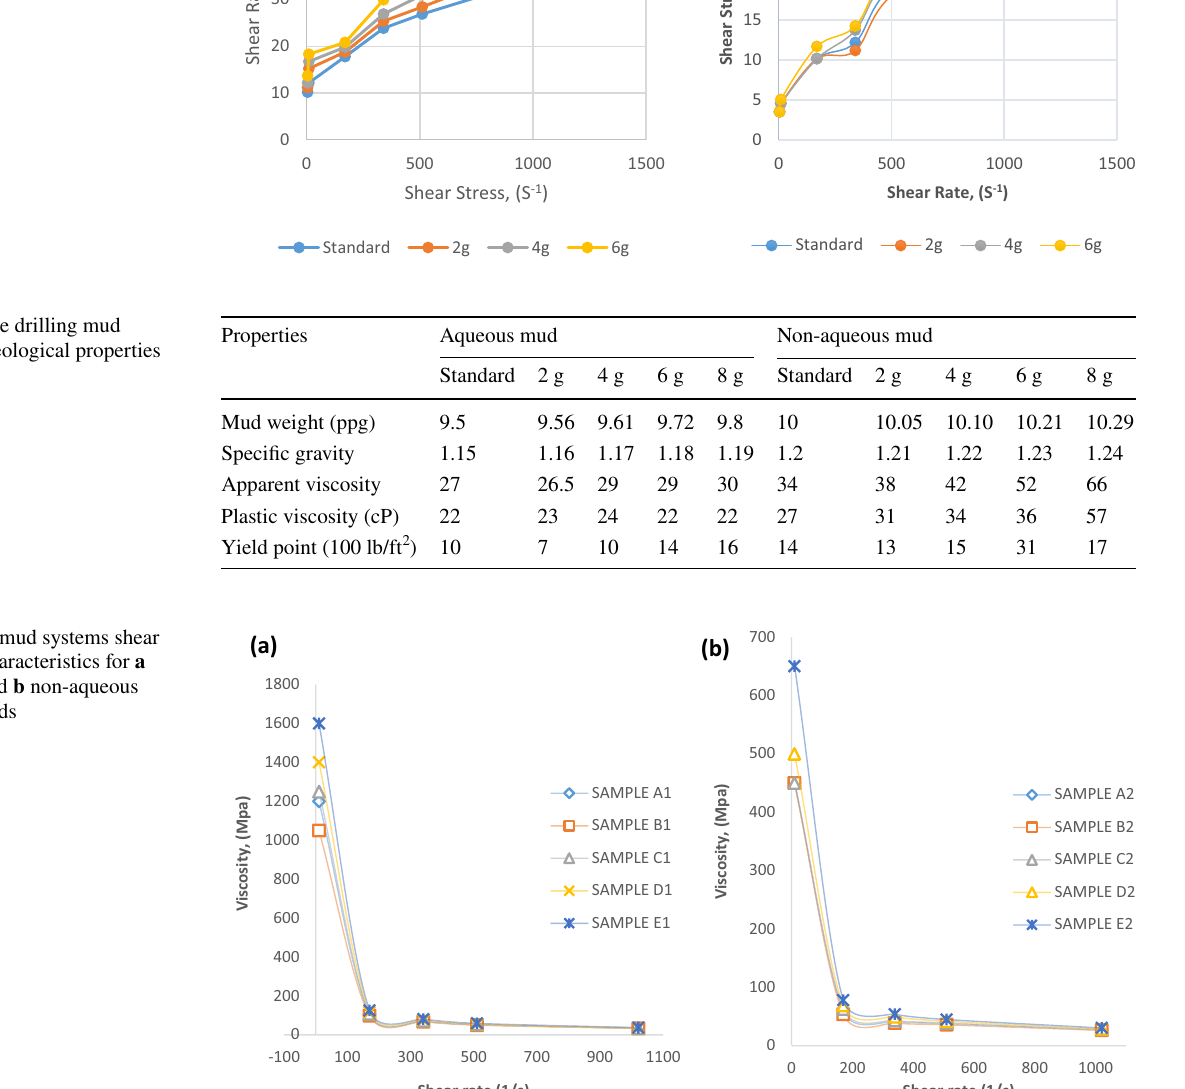
Table 4 The drilling mud systems rheological properties